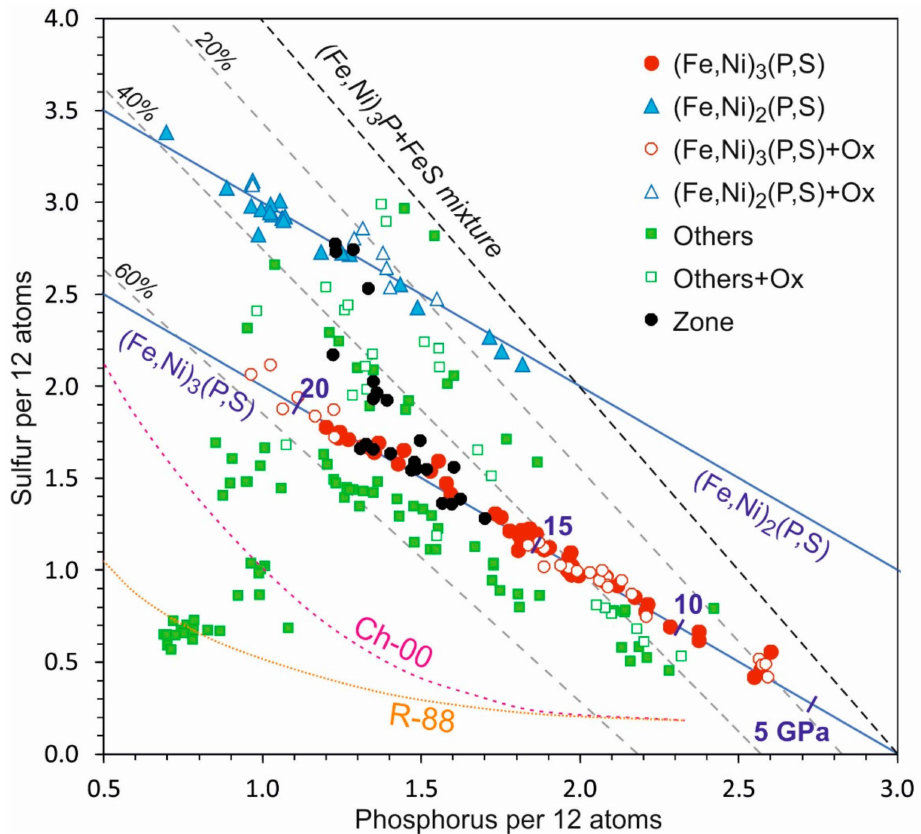
Figure 6. Phosphorus vs, sulfur contents in (Fe,Ni) 3 (P,S) melt pockets from Elga meteorite. Ox–partially oxidized melt pockets. Others correspond to intermediate non-stoichiometric FNX compositions. “Zone” shows the compositional variation of Fe–Ni–P–S alloy from schreibersite to troilite (see Figure 2 and Table S2). Pressure values in GPa correspond to maximum S solubility in Fe 3 P 1-x S x alloys [20]. Black dashed line shows compositions of mechanical mixture between schreibersite and troilite. Grey dashed lines are same with an addition of 20, 40, and 60 mol.% of (Fe,Ni)-metal. Dotted lines show the limit of